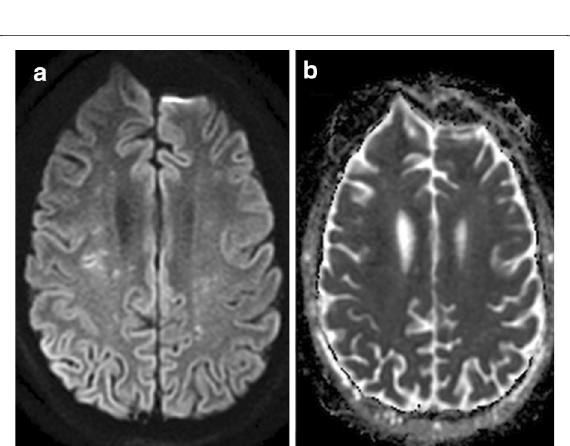
Fig. 6 A case representing the starfield pattern of restricted diffusion. MRI scan of an 18-year-old man with a closed displaced fracture of the left femoral shaft after a high velocity motor vehicle accident. Diffusion-weighted MR Image (10000/89; b value, 1000 s/ mm 2 ) showing foci of hyperintensities within both centrum ovale ( a ), and the corresponding ADC map confirming restricted diffusion ( b ). Published under the permission of G. Bierry and